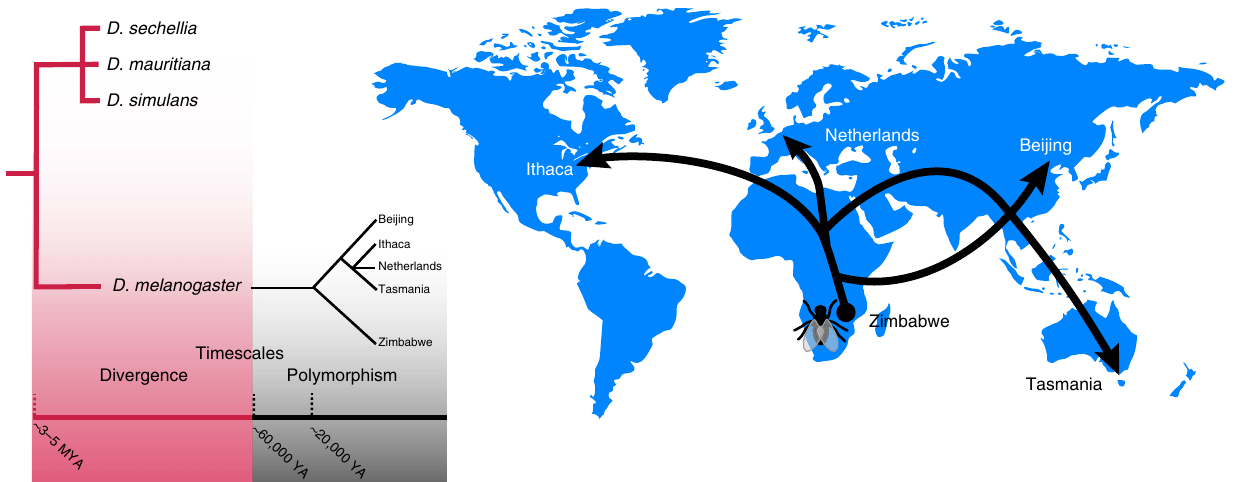
Figure 1 | D. melanogaster ’s recent global expansion. Left: tree schematic illustrating D. melanogaster ’s relationship with its most closely related species, and the relationship between the five D. melanogaster populations from the global diversity lines. The most recent common ancestor shared with the D. simulans species trio was B 3–5 million years ago (MYA). The non-African populations are estimated to have branched off B 20,000 years ago (YA), and it is believed that the African ancestral population of D. melanogaster began to expand B 60,000 YA. The separation between the two trees (red versus black) emphasizes the two timescales examined in this study. Right: cartoon representation of the expansion of the five populations from Africa around the